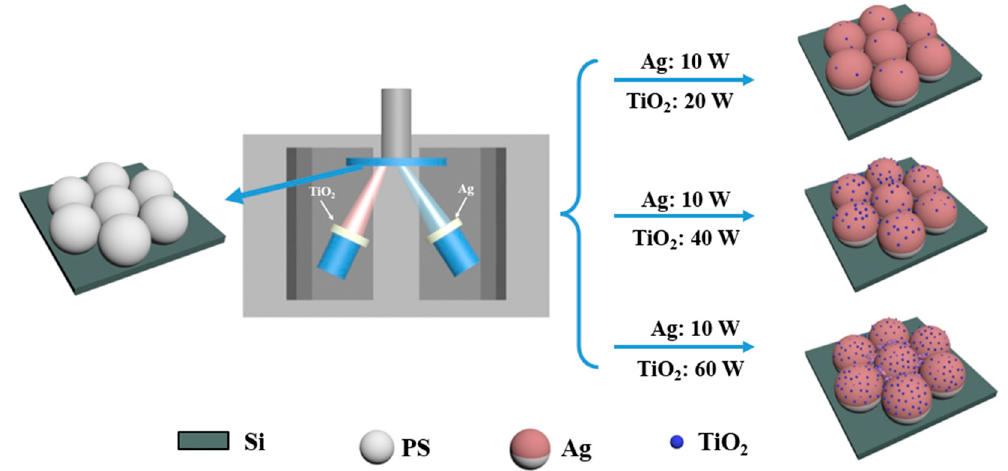
Figure 1. Schematic diagram of deposition of TiO 2 -Ag composites.